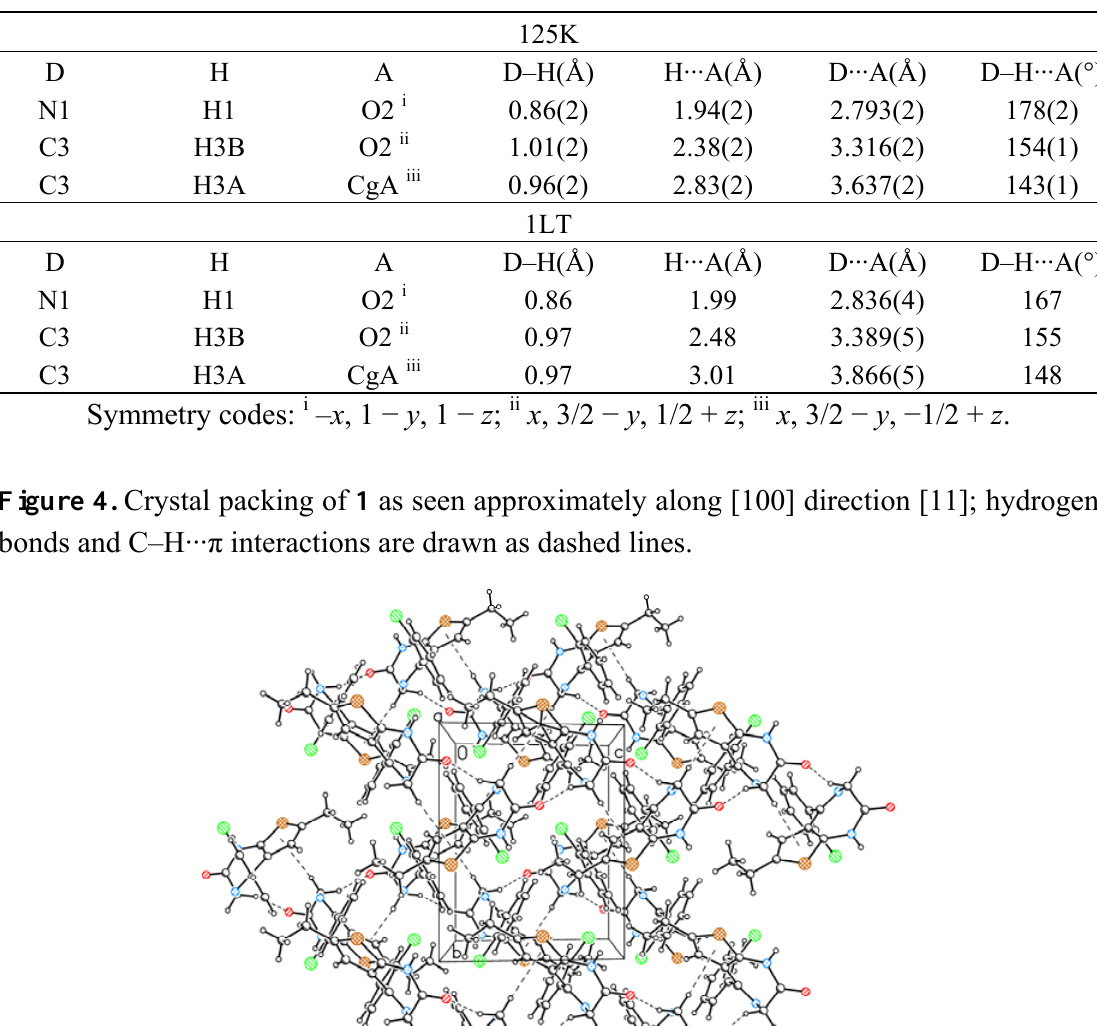
Table 2. Hydrogen bond data (Å, °). CgA denotes the centroid of the five-membered ring.